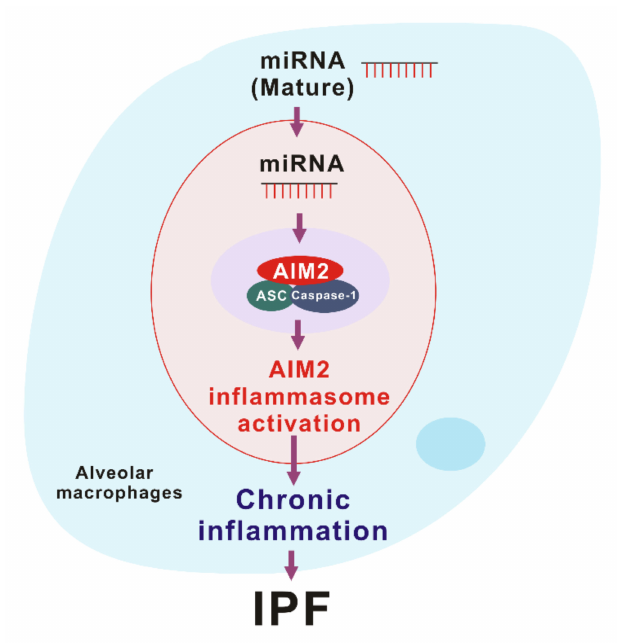
Figure 3. The role of miRNA-dependent AIM2 inflammasome activation in idiopathic pulmonary fibrosis